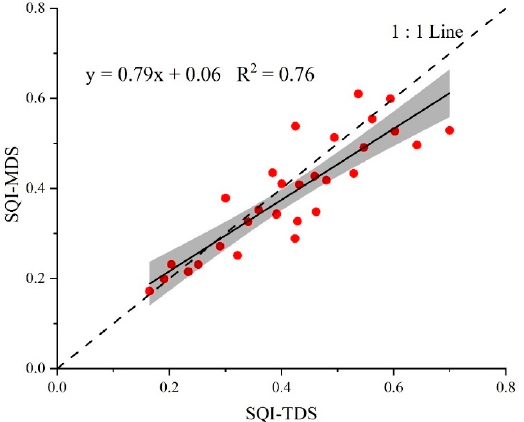
Figure 4. Correlation between soil quality index of the minimum data set and the full data set ( n = 30). Table 5. Classification and proportion of soil quality grades using different analysis methods. SQI